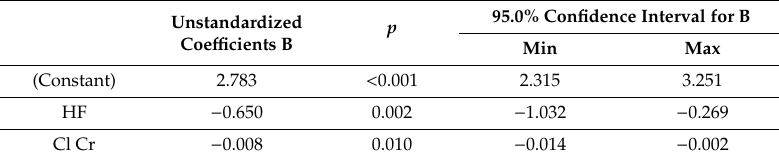
Table 3. Multivariate analysis of trough plasma levels.